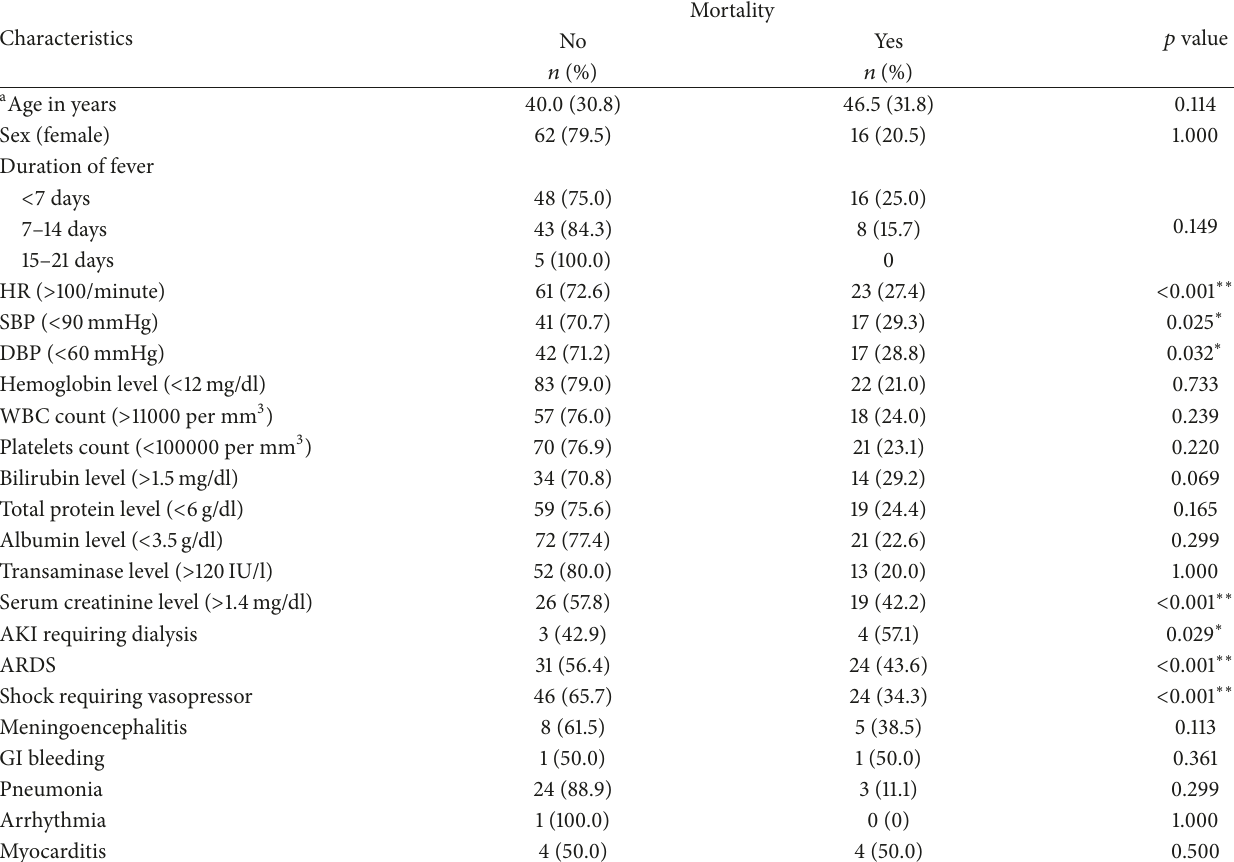
Table 2: Bivariate analysis of outcome measures of scrub typhus (𝑛 = 120 ).